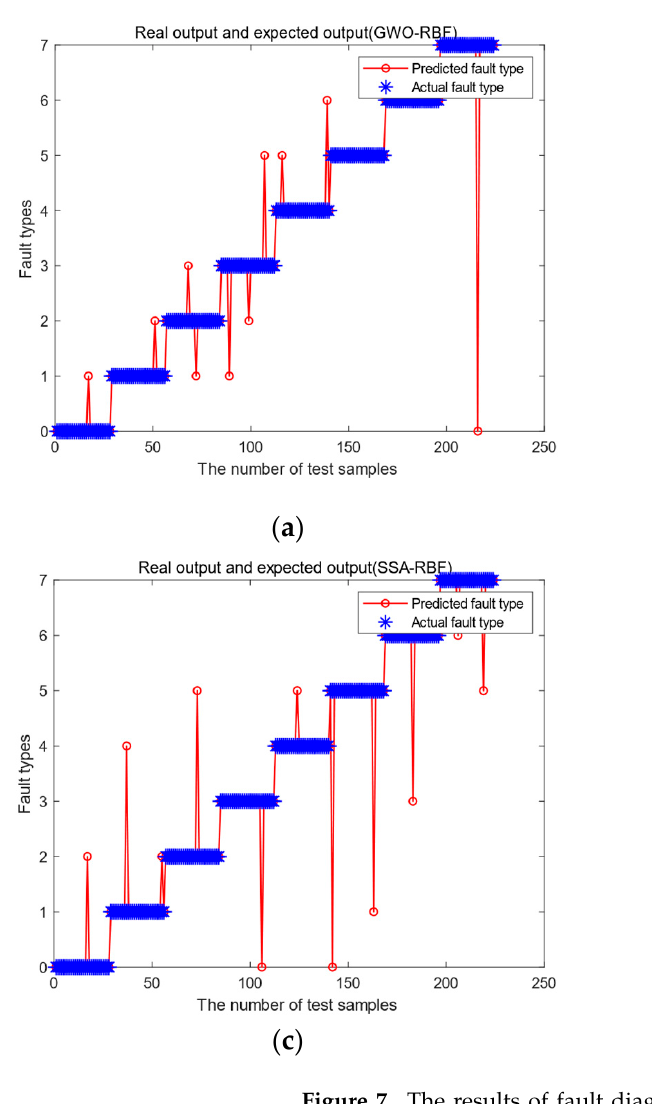
Figure 8. The MSE of the metaheuristic-based RBF network in comparison experiments. In the third set of experiments, we used existing neural network models and classical neural network models (BP, ELM, and PNN) to compare with the CASAWOA-RBF model. The average accuracy for each model and the corresponding diagnosis results are given in Table 10 and Figure 9, respectively.